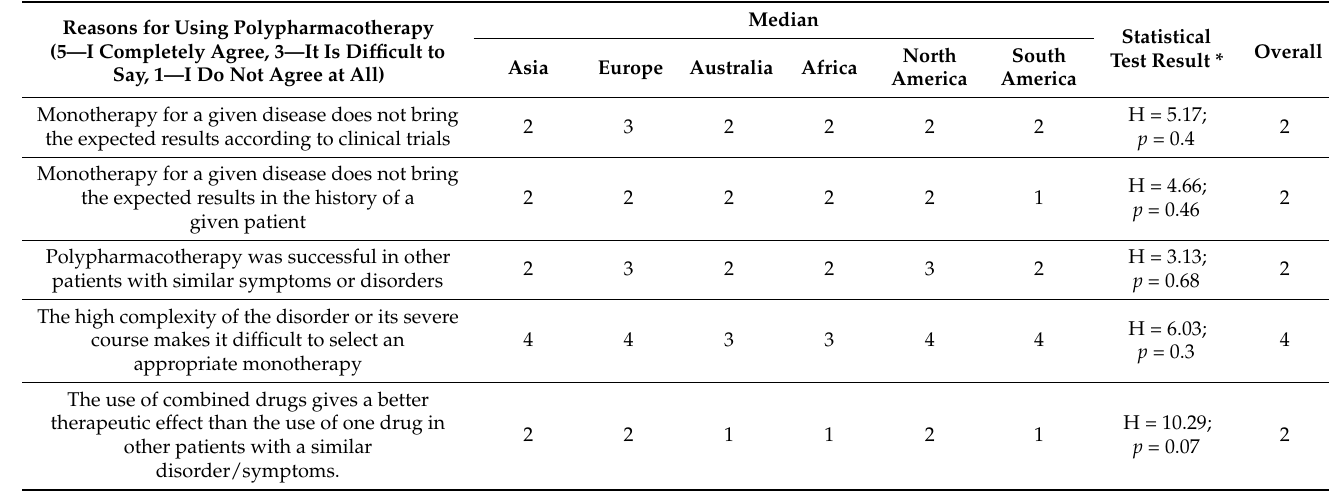
Table 3. Reasons for using polypharmacotherapy by the surveyed group of psychiatrists.